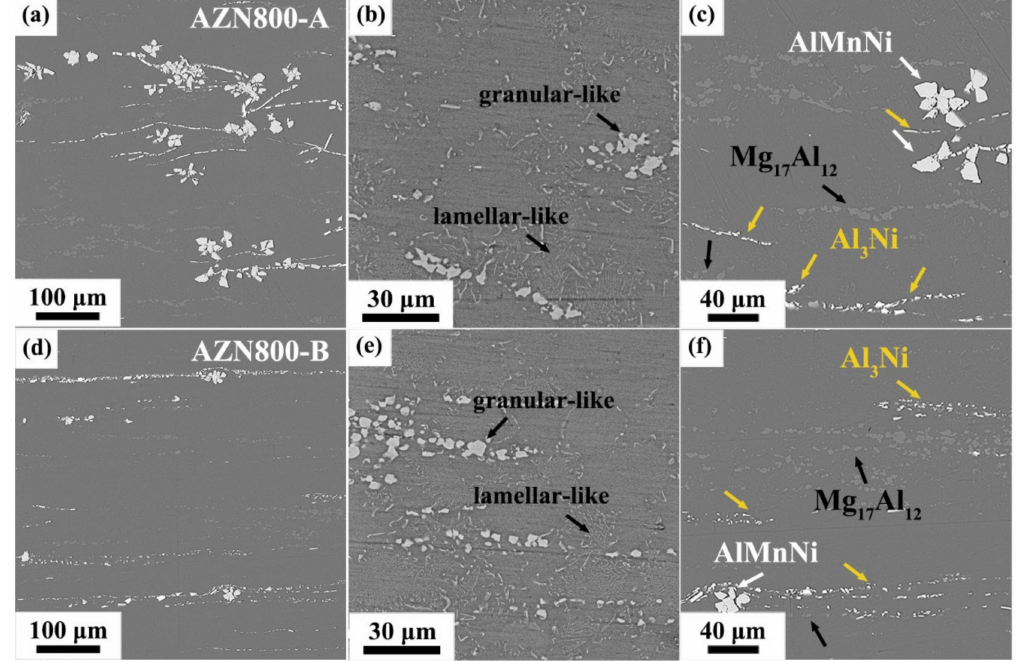
Figure 2. SEM micrographs of the extruded alloys ( a – c ) AZN800-A, ( d – f )